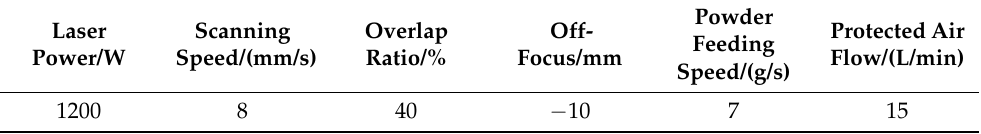
Figure 1. ( a , b ) Morphology of FeCoCrNiAl HEA powder, ( c ) schematic diagram of laser cladding process, ( d ) FeCoCrNiAl HEA coating. Table 1. Laser cladding process parameters for FeCoCrNiAl HEA coatings.